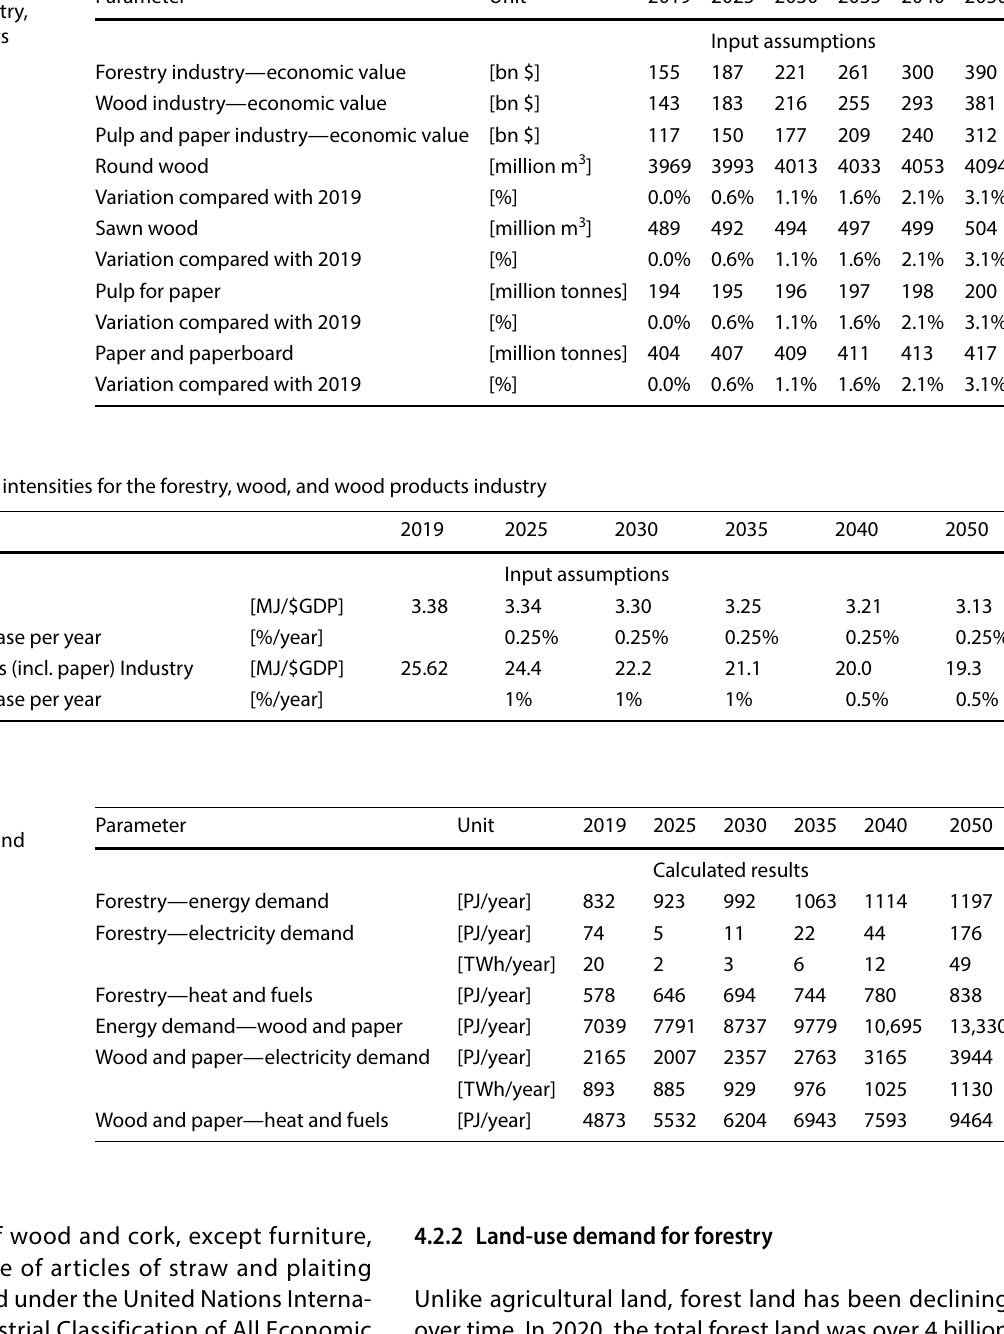
Table 8 Global economic development of the forestry, wood, and wood products industry